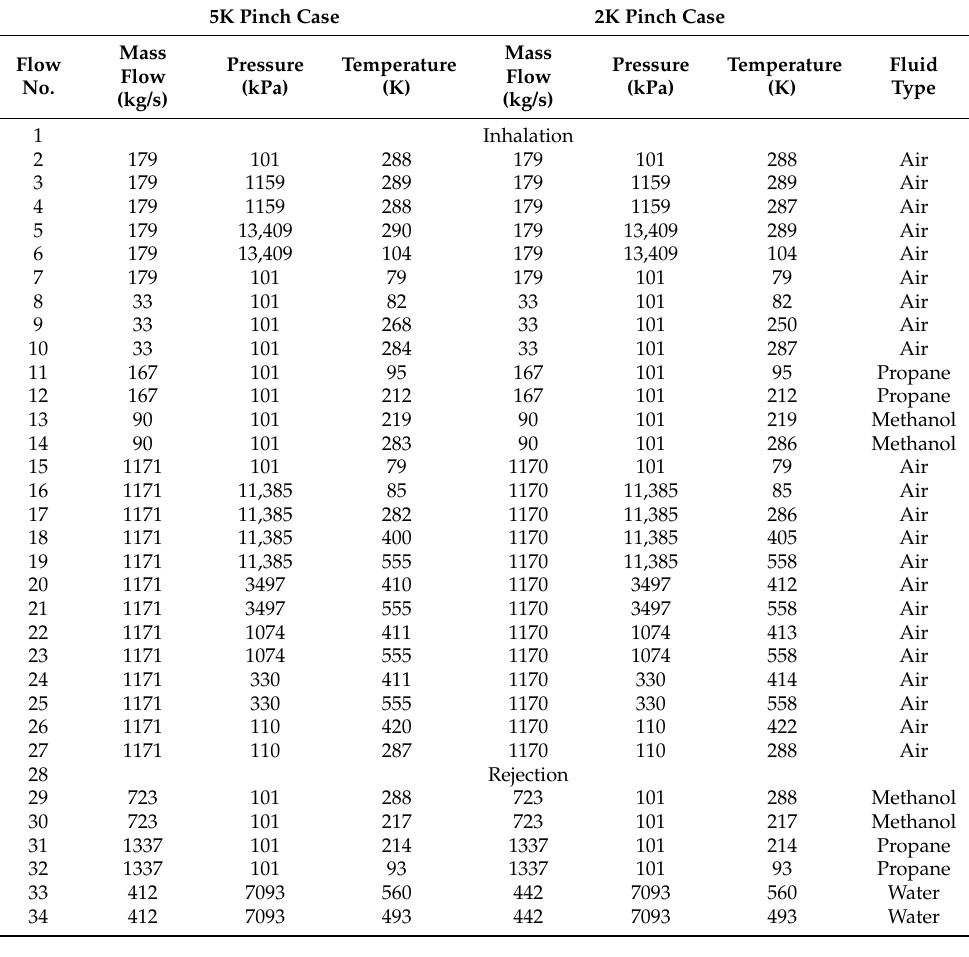
Table 7. The main steam parameter for 5K pinch (left) and 2K pinch (right). 5K Pinch Case 2K Pinch Case Flow